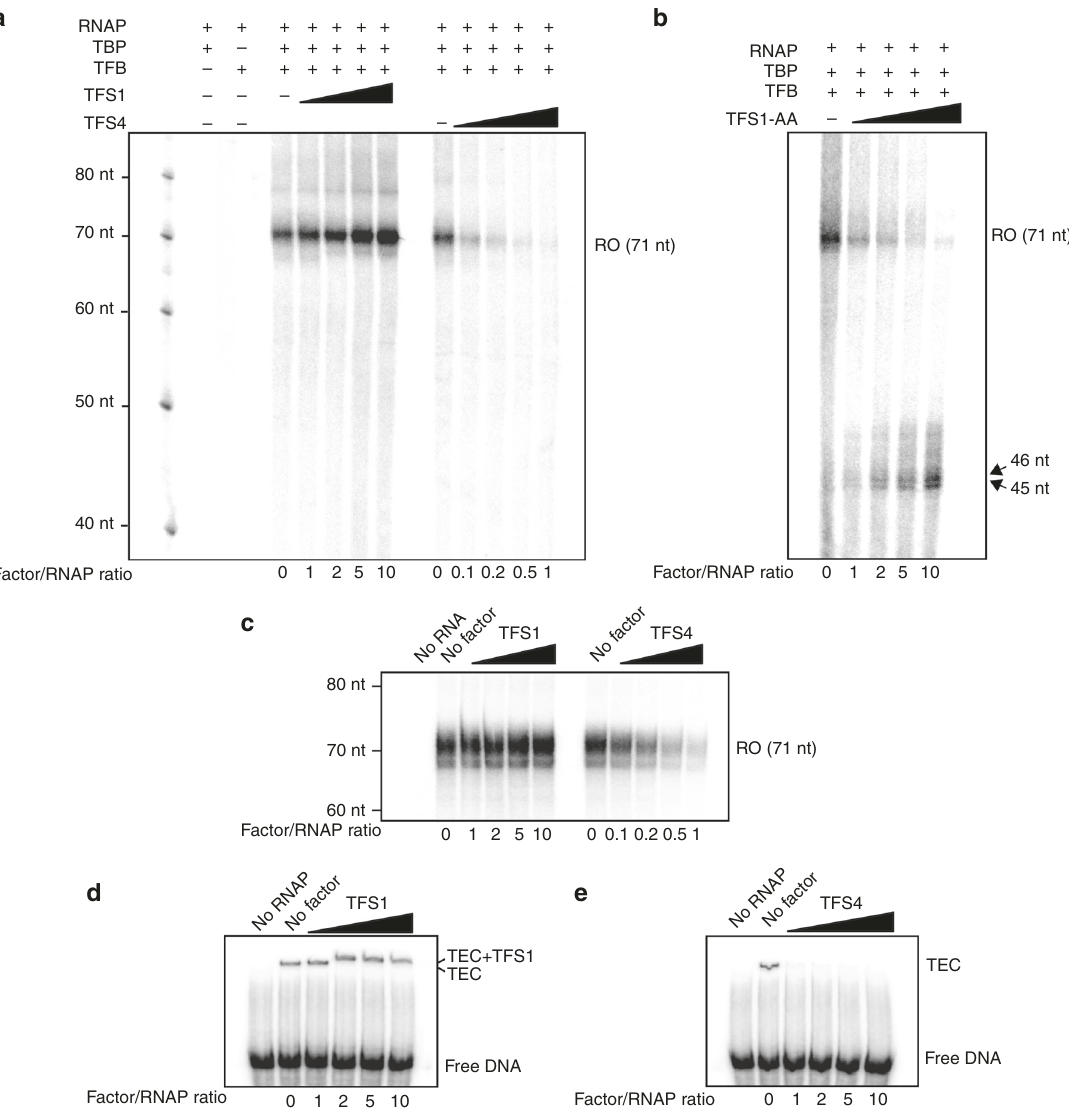
Fig. 4 TFS4 inhibits promoter-directed transcription initiation, and transcription elongation. a , b Promoter-directed transcription assays directed by the SSV1-T6 promoter in the presence of TFS1, TFS4 ( a ) or TFS1-AA ( b ). The addition of TFS1 stimulates productive transcription whereas TFS4 inhibits it. The TFS1-AA active site mutant reduces transcription processivity. c Transcription elongation assays using a synthetic scaffold template in the presence